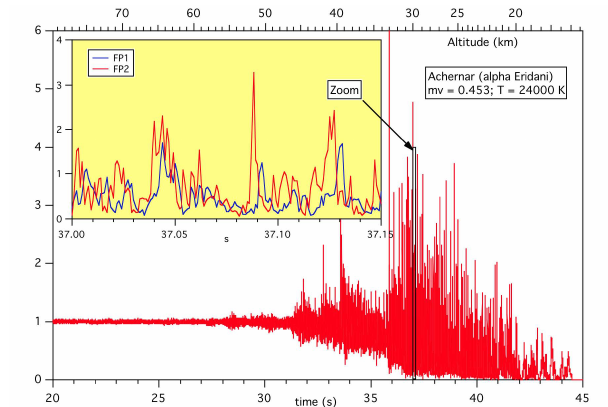
Fig. 17. Example of real scintillation recorded at 1kHz by Gomos. Tangent altitude is shown on a non-linear scale at the top of the graph. The zoom shows the signals from “blue” and “red” photometers (see the text for